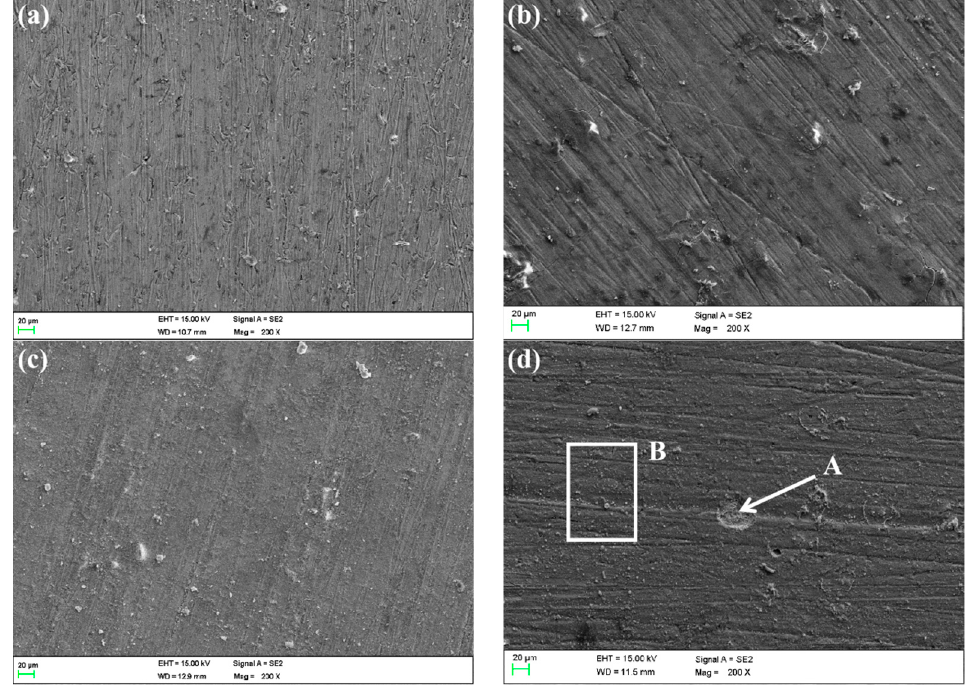
Figure 15. SEM images of MZ surfaces in different flowing rates of seawater: ( a ) 0 m/s, ( b ) 1 m/s, ( c ) 3 m/s, ( d ) 5 m/s. Table 3. Elemental composition of MZ at different flowing rates of seawater (at%). Flowing